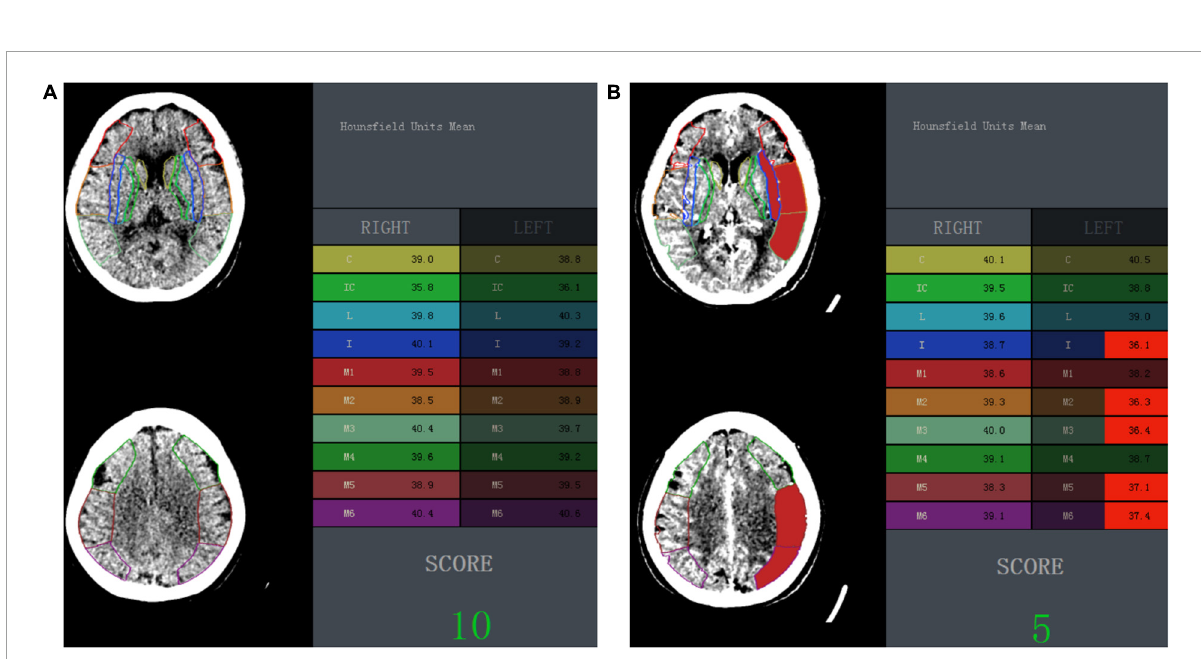
FIGURE3 One example illustrating the automated ASPECTS and wHU-ASPECTS value. (A) In a 68-year-old woman with symptomatic onset to CT time within 4.5 h and CTP-based ischemic core of 18.31 ml, the automated ASPECTS on NCCT image was 10, and wHU-ASPECTS on NCCT was –0.882, both indicated a correct classification of ischemic core size according to the maximum Youden index-associated cutoff value. (B) In the same patient, the automated ASPECTS on CTA source image was 5 and indicated a correct classification, while the wHU-ASPECTS on CTA was –0.764 and failed to make a correct classification. ASPECTS indicates Alberta Stroke Program Early CT Score; wHU-ASPECTS, sum of the products of regional relative HU values times corresponding weighting